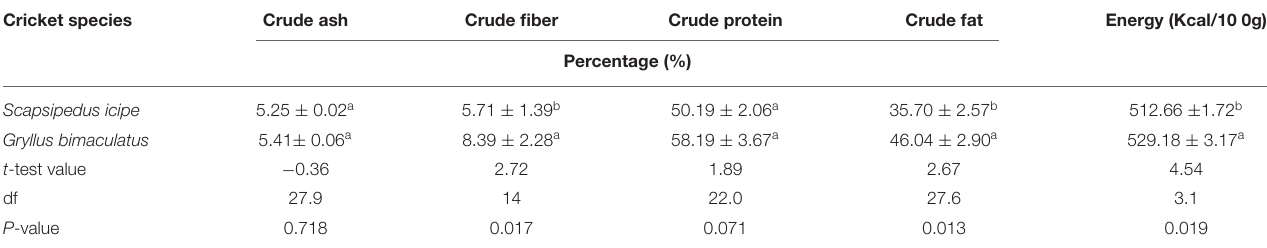
TABLE 1 | Crude ash, crude fiber, crude protein, crude fat, and energy levels of Scapsipedus icipe and Gryllus bimaculatus on dry matter basis (mean ± SE). Cricket species Crude ash